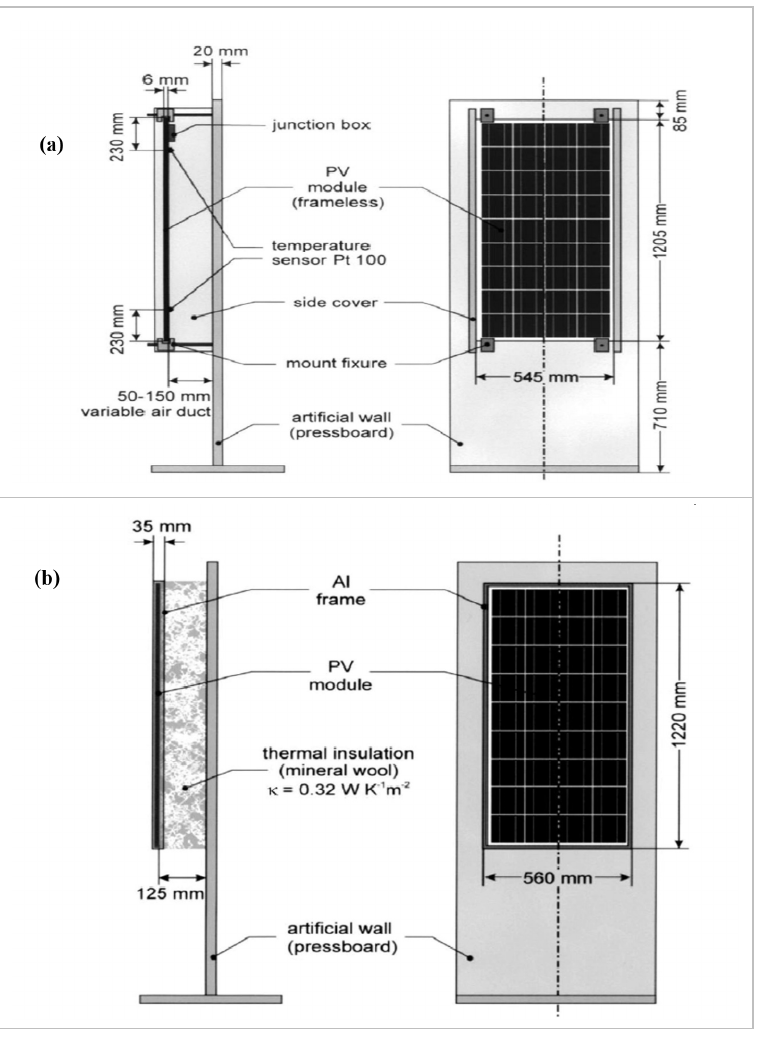
Figure 9. The proposed PV module ( a ) with ventilation ( b ) without ventilation. Reproduced with permission from ref. [160]. Copyright 1999 Elsevier.